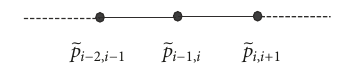
Figure 3: The external vertices that cannot propagate.